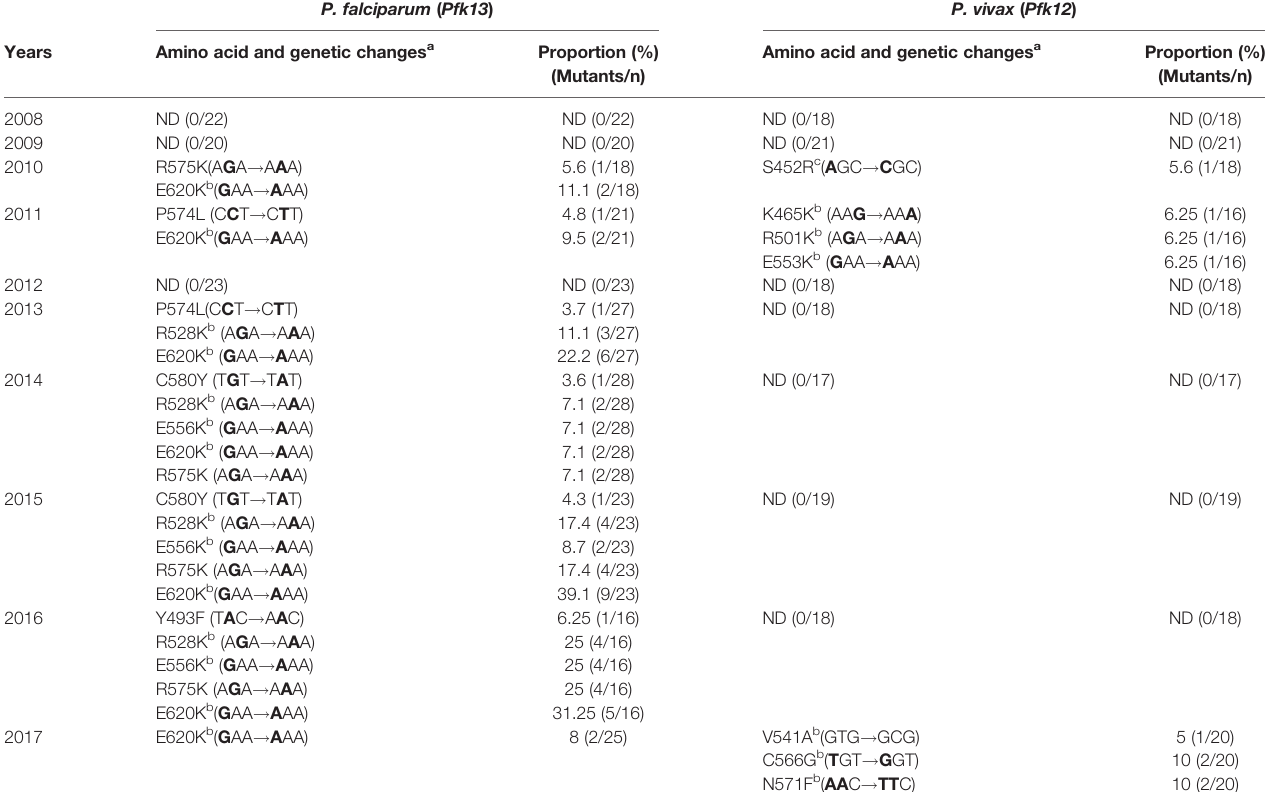
TABLE 1 | Statistical analysis of the mutation sites and their frequency in pfk13 and pvk12 .